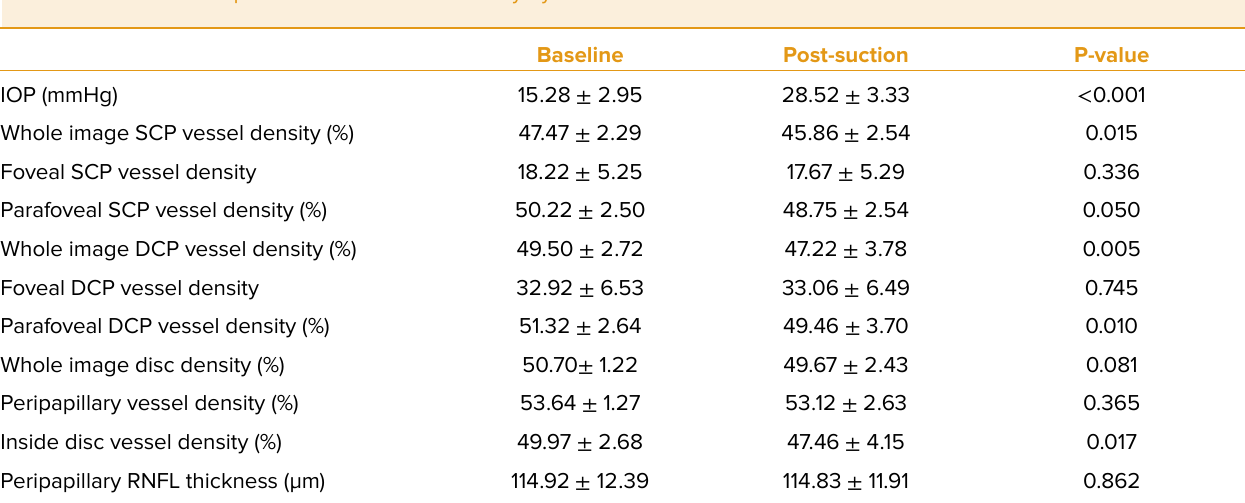
Table 2. Baseline and post-suction values in healthy